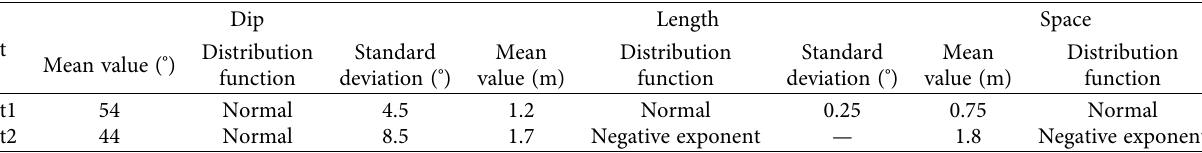
Figure 2: Generation of the discrete fracture network (DFN) for the rockmass. Table 1: Defect sets and input data for generating the